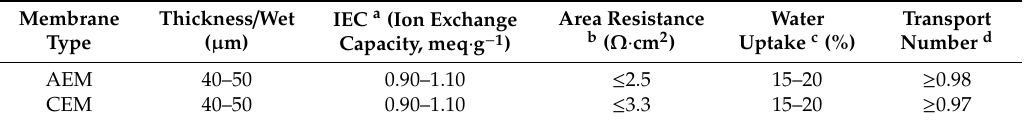
Table 1. The main characteristics of anion exchange membranes (AEM) and cation exchange membranes (CEM) used in the experiments.